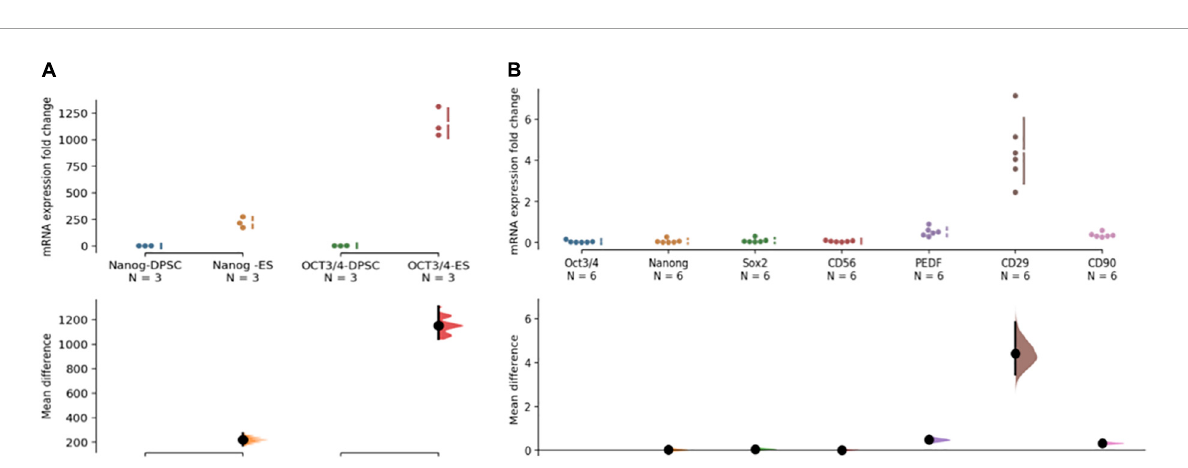
FIGURE2 Primary human dental pulp stem cells (DPSC) are predominantly mesenchymal in nature. (A) DPSC express pluripotency markers Nanog and OCT 3/4 at 100-1000 fold lower levels compared to human embryonic stem cells (hESC). The quantitative PCR analysis was performed on mRNA from 3 different primary DPSC lines and compared against different replicates from one HESC line. (B) Primary DPSC express higher levels of mesenchymal markers (PEDF/CD29 and CD90) compared to pluripotency markers (Oct 3/4, Nanog and Sox2). CD56 expression is seen at low levels equivalent to that of Oct 3/4. The analysis was performed on cells from 3 different cell lines and 2 different passages with a total n = 6. In both graphs, raw data and spread is shown as a Cumming estimation plot on the upper axes and mean difference compared to control sample are plotted as bootstrap sampling distributions on the lower axes. Each mean difference is depicted as a dot and each 95% confidence interval is indicated by the ends of the vertical error